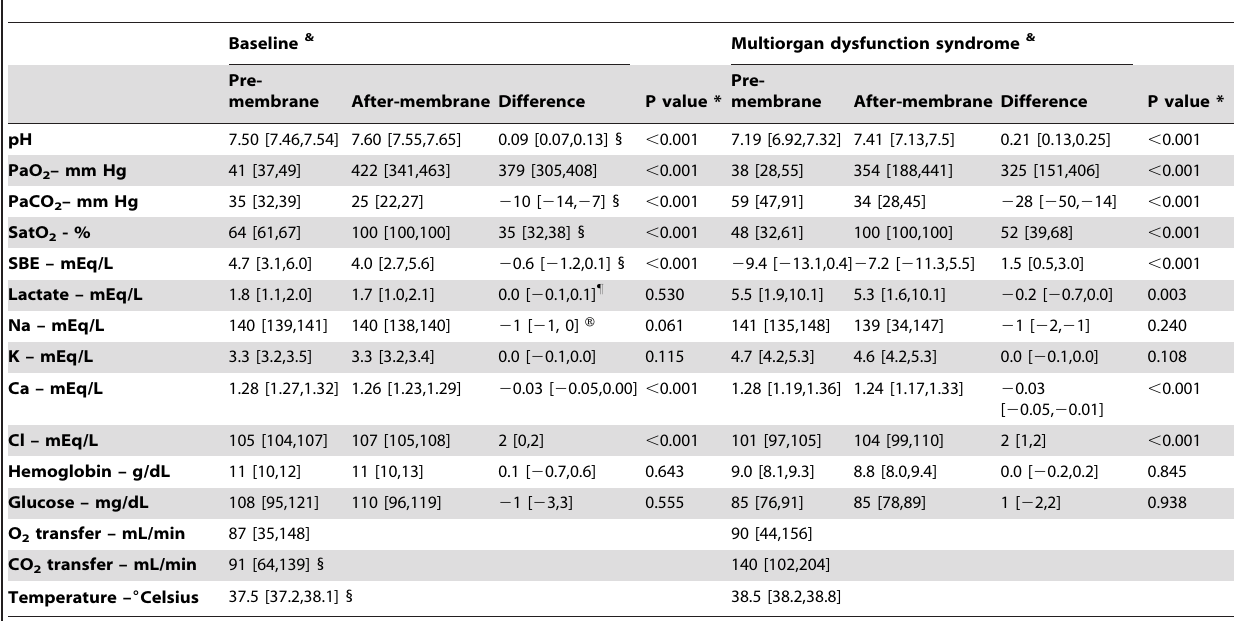
Table 3. Comparison of laboratory variables between the blood samples acquired before and after the oxygenation membrane, during the baseline and the MOF clinical